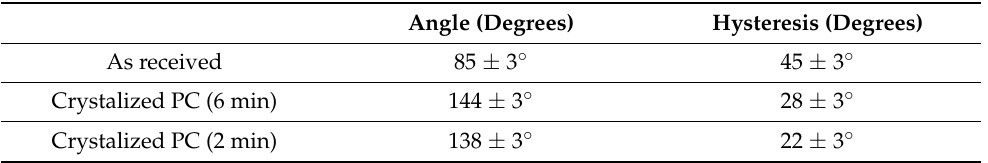
Table 1. Contact angles measurement for as received and crystallized polycarbonate surface after 6 and 2 min treatment durations. The contact angle and hysteresis presented in the table provides the average values after 12 measurements. ± 3 ◦ is related to experimental errors due to droplet spreading. Angle